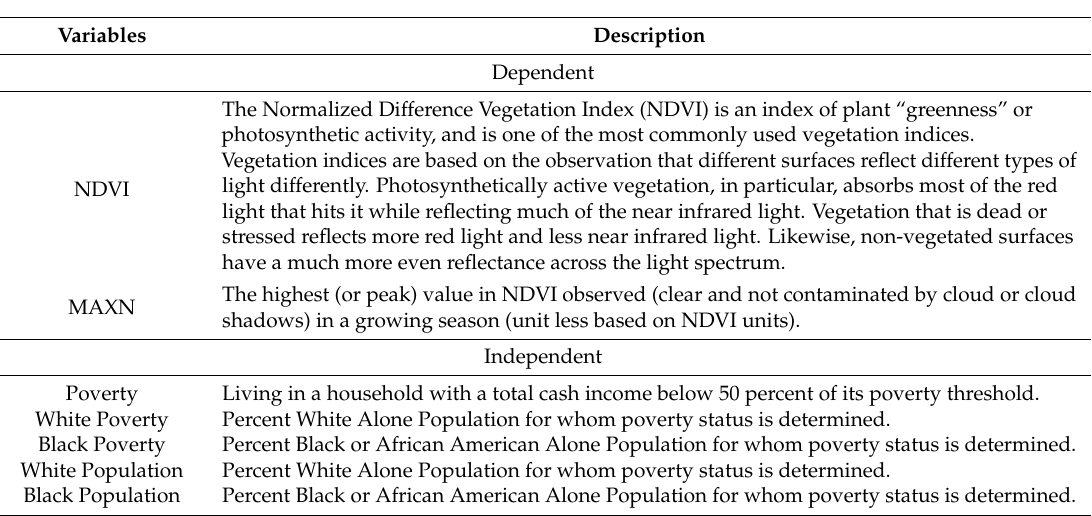
Table 1. Descriptive Variables and